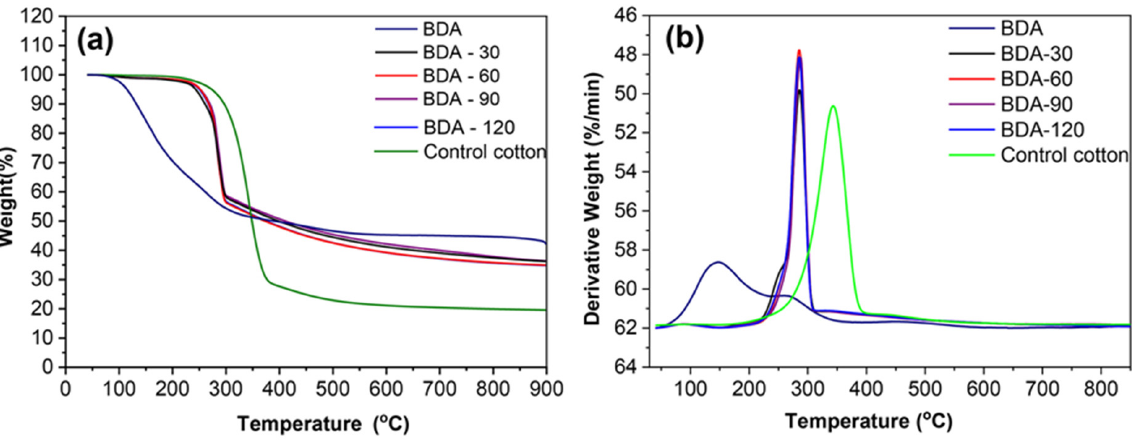
Figure 7. ( a ) TG and ( b ) DTG curves of BDA, control sample, and BDA ‐ treated samples (3 curing times, 50 LCs). Table 4. TG analysis data of control sample and BDA treated samples (3 curing times, 50 LCs) un ‐ der N 2.